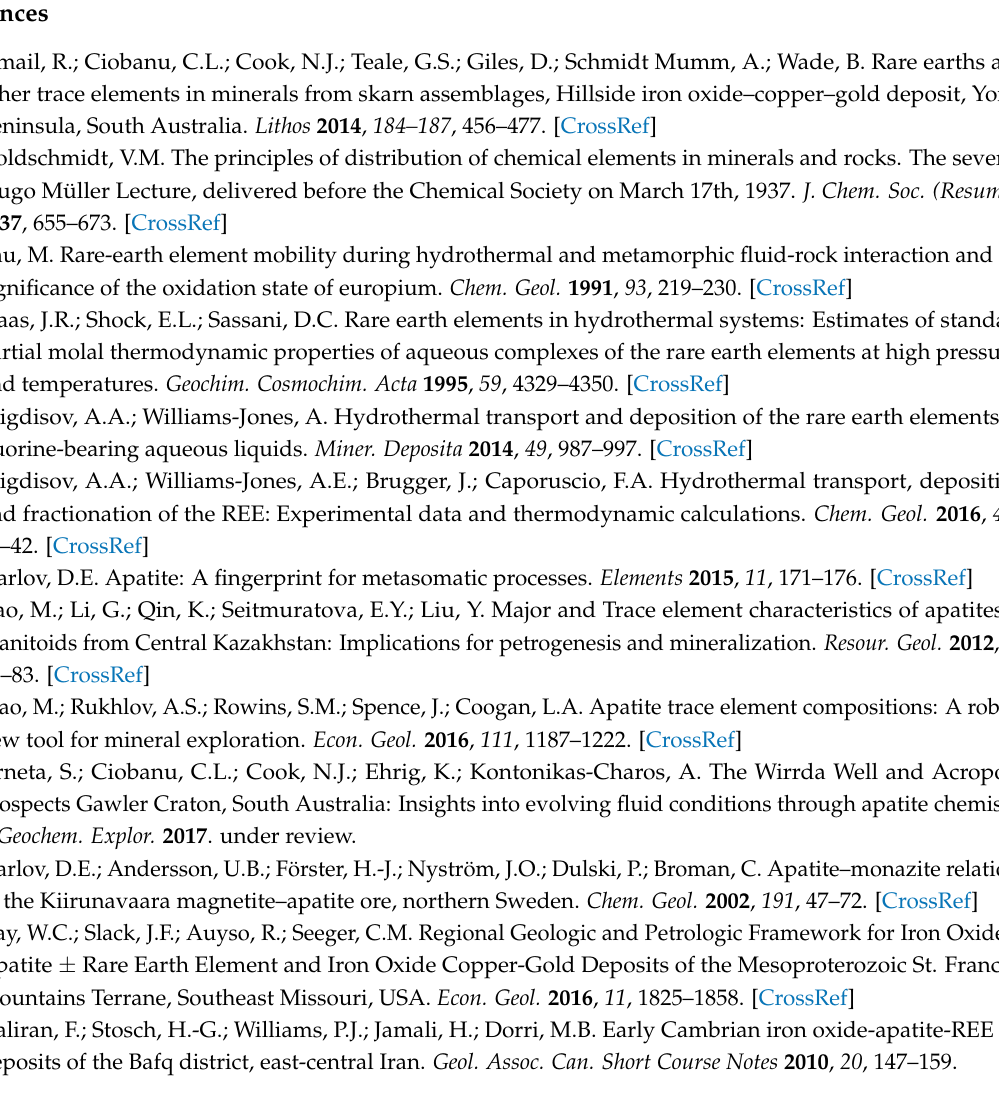
Table S1: Typical minimum detection limits (mdl) for LA-ICP-MS analysis, Table S2: Standards, X-ray lines, count times and typical minimum detection limits (mdl) for electron probe